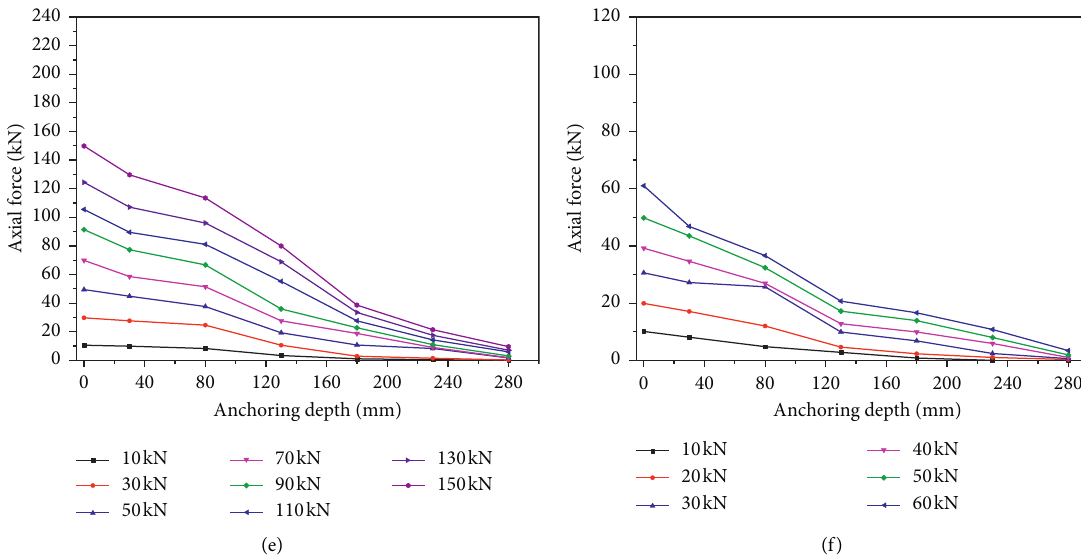
Figure 10: Axial force distribution diagrams under different loads. (a) C20-50 ° C specimen. (b) C40-50 ° C specimen. (c) C60-50 ° C specimen. (d) St-50 ° C specimen. (e) C40-20 ° C specimen. (f) C40-70 ° C